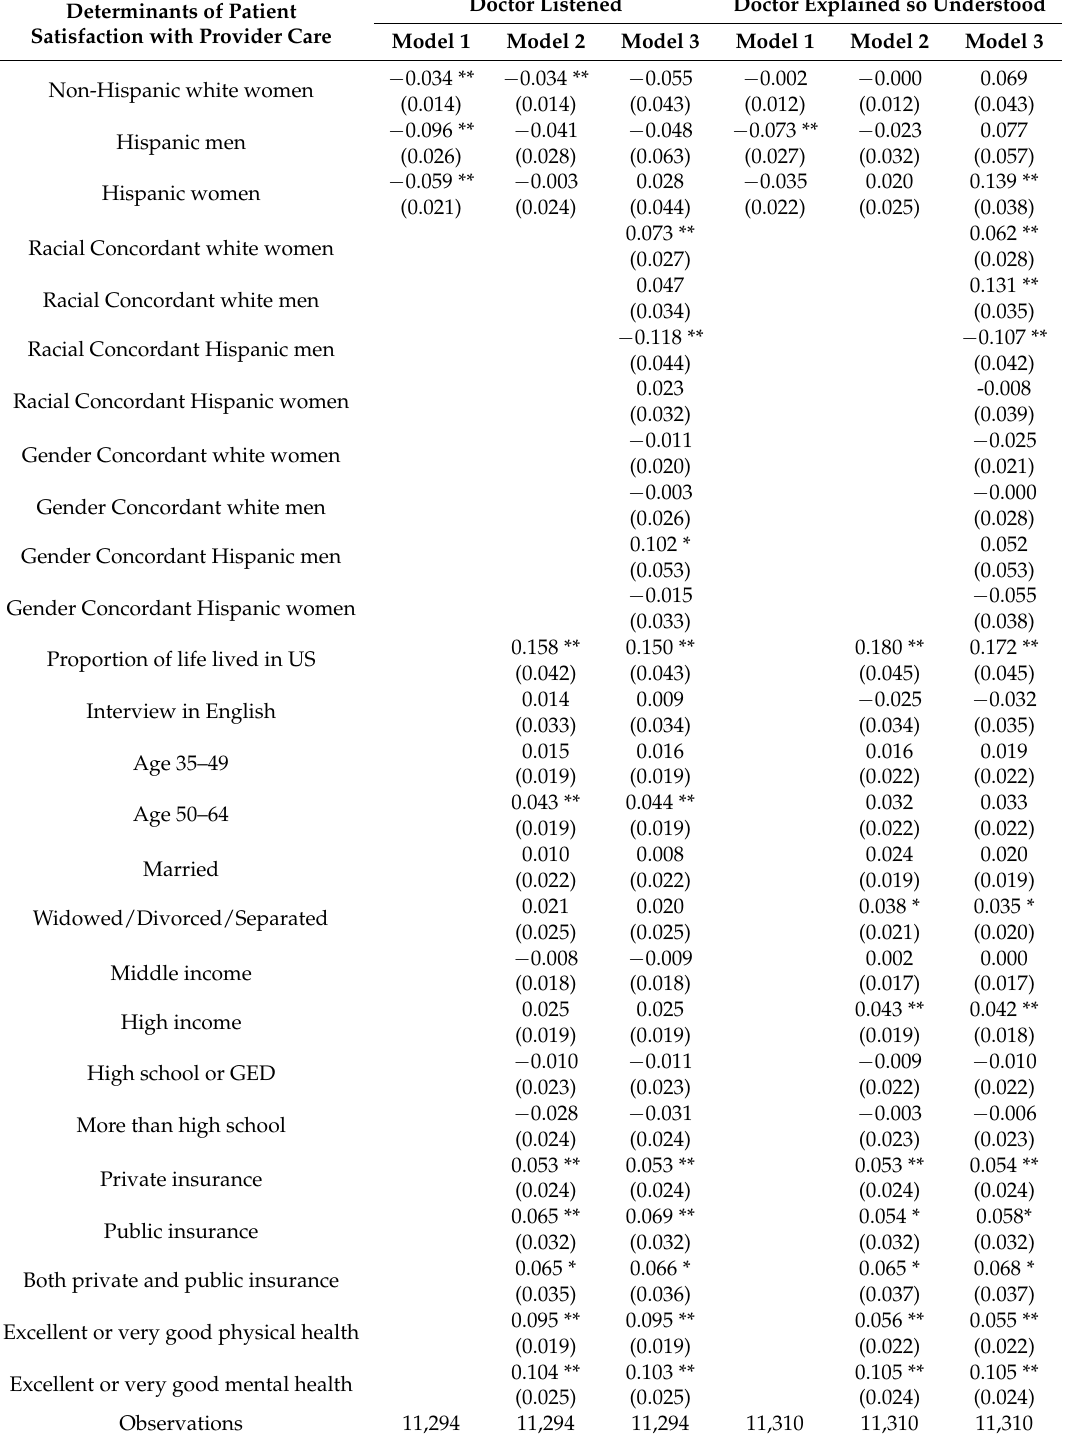
Table 3. Determinants of Patient Satisfaction with Provider